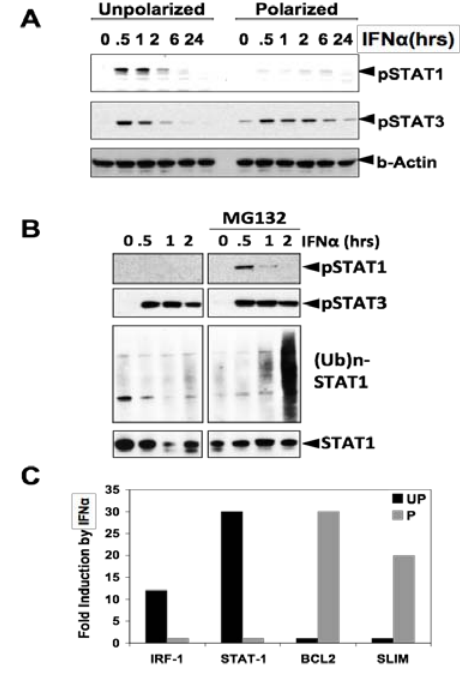
Figure 1. STAT3 is preferentially activated by IFNα, while STAT1 is degraded by the proteasome in polarized IEC. ( A ) Polarized or unpolarized HCA-7 cells were stimulated with IFNα (10 ng/mL) for the indicated time period and the indicated proteins were measured by immunoblotting; ( B ) Polarized HCA-7 cells were stimulated with IFNα (10 ng/mL) for the indicated time period in the absence or presence of MG132 (10 µM) and the indicated proteins were measured by immunoblotting. To detect ubiquitination of STAT1, STAT1 was immunoprecipitated and blotted with anti-ubiquitin antibody; ( C ) Polarity-dependent gene activation by IFNα in IECs. Polarized (P) or unpolarized (UP) HCA-7 cells were stimulated with IFNα (10 ng/mL) for 1 hr and the induction of indicated genes by IFNα was measured by qPCR. The data represents one of two independent experiments with similar